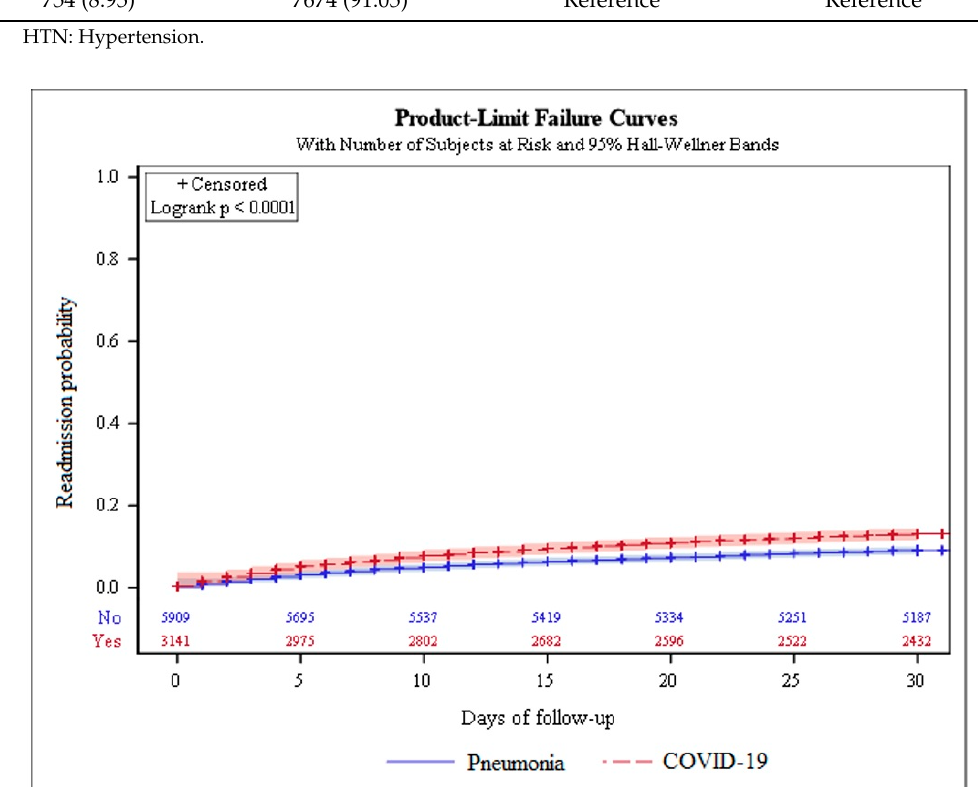
Figure 2. The 30 day risk of hospital readmission between COVID-19 and pneumonia patients. In additional analyses, we investigated the extrapulmonary reasons for readmission. About 7.23% of the readmitted were with renal diseases, 1% of them with acute kidney in- jury. In addition, 7% of the readmitted were due to cardiovascular diseases, including 4.19%, 0.34%, and 1.13% that were readmitted due to decompensated heart failure, arrhythmia, and myocardial infarction. Very few patients (0.6%) presented with